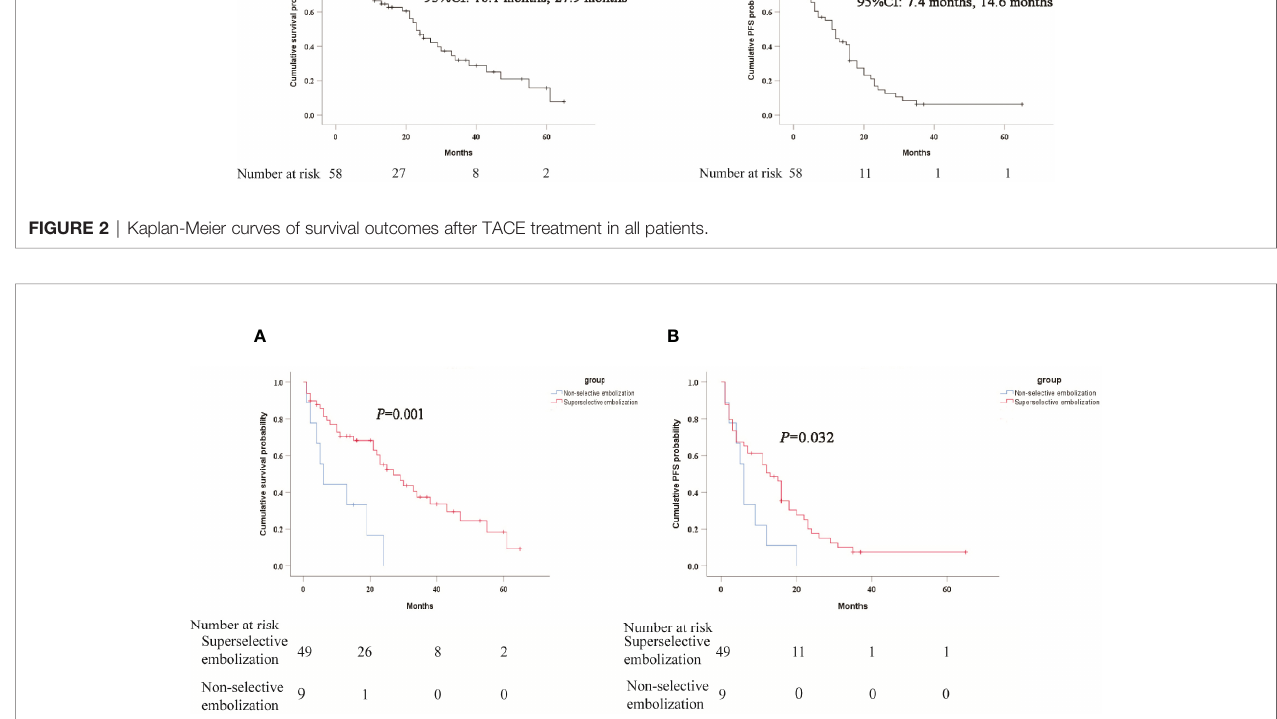
FIGURE 3 | Kaplan-Meier curves of subgroup analysis survival outcomes by selective